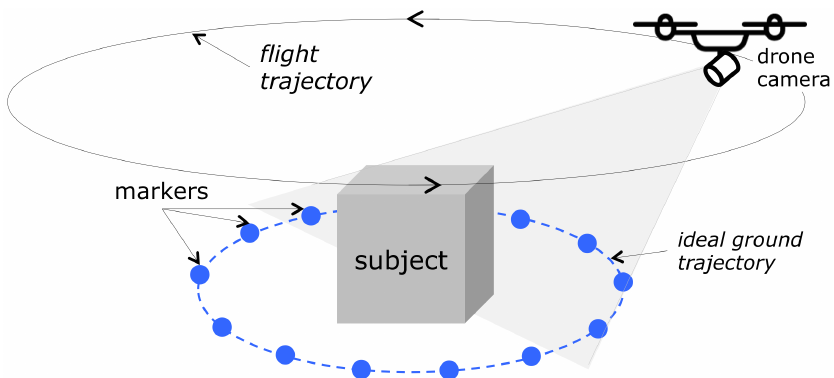
Figure 1. The acquisition setup. The drone has to fly at least one round along the trajectory surrounding the object to